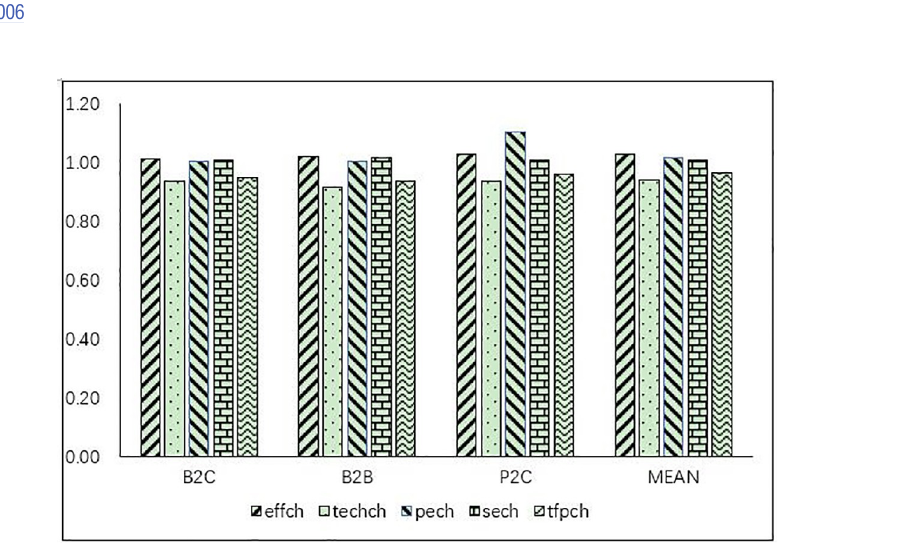
Fig 2. Summary of the average Malmquist index of different types of e-commerce